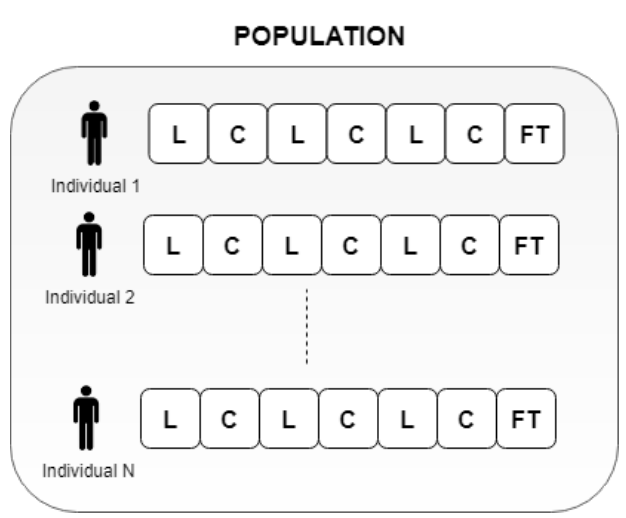
Figure 4. Chromosome representation for the population. Note that the genes are real values for L, C, and integer for FT (Filter